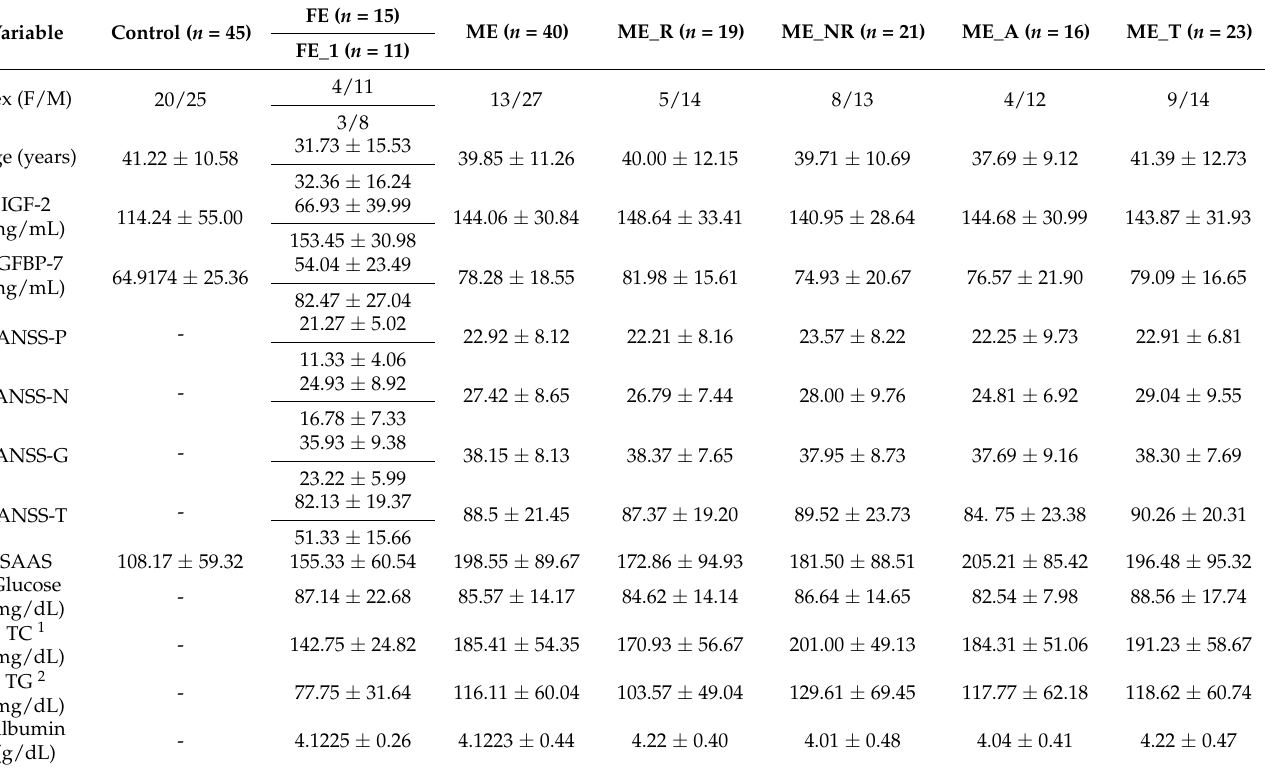
Table 1. Demographic and clinical